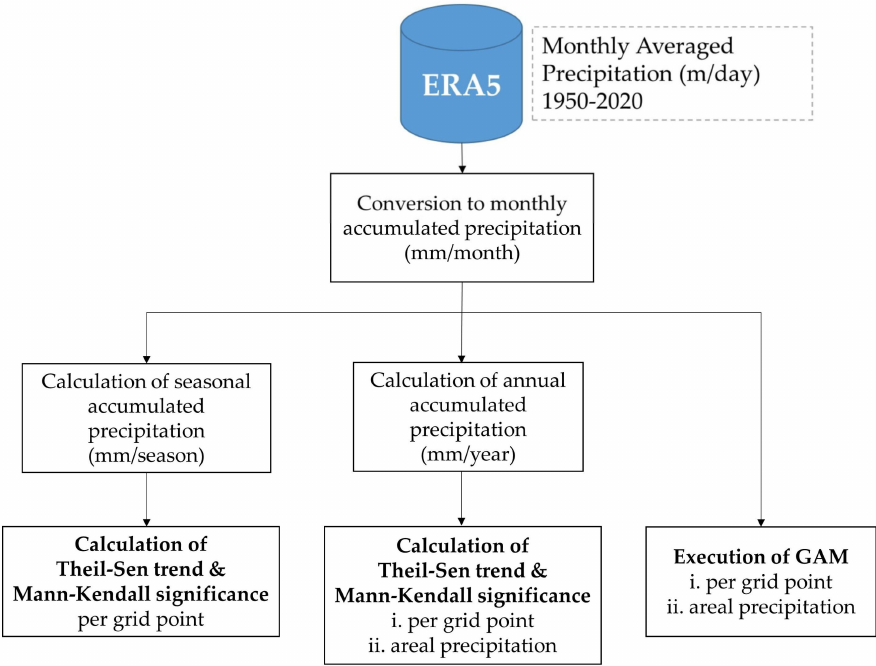
Figure 2. Flowchart demonstrating the main data processing and calculation